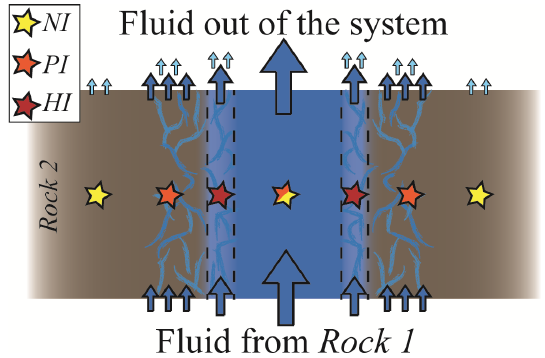
Figure 8. Schematic section of a channelled fluid flow where differ- ent degrees of exchange between the fluid and the rock may occur in spatial proximity. From the host rock perspective, the NI case de- scribes the distal portion of the rock walls where no fluid infiltrates, the PI case the intermediate portion where a limited amount of ex- ternal fluid is available and the HI case the pervasively infiltrated rock proximal to the vein. From the fluid perspective, the NI case describes the fluid flow in the centre of the channel, for which the exchange with the rock walls is negligible; the PI case the situation in which part of the fluid does not react with the wall rock and part equilibrates with it, and the HI case the situation in which no fluid flow occurs without equilibration with the host